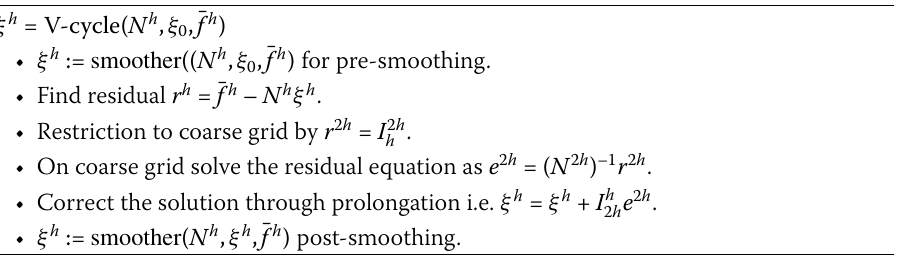
Algorithm 1 V-cycle multigrid